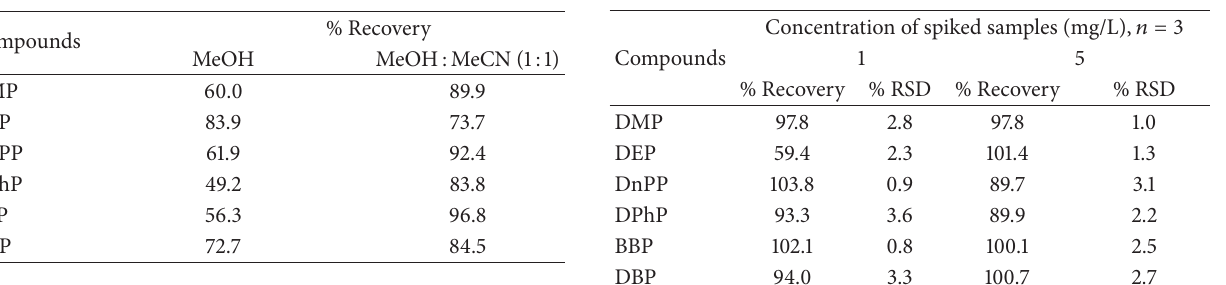
Table 5: The recoveries for the spiked samples.